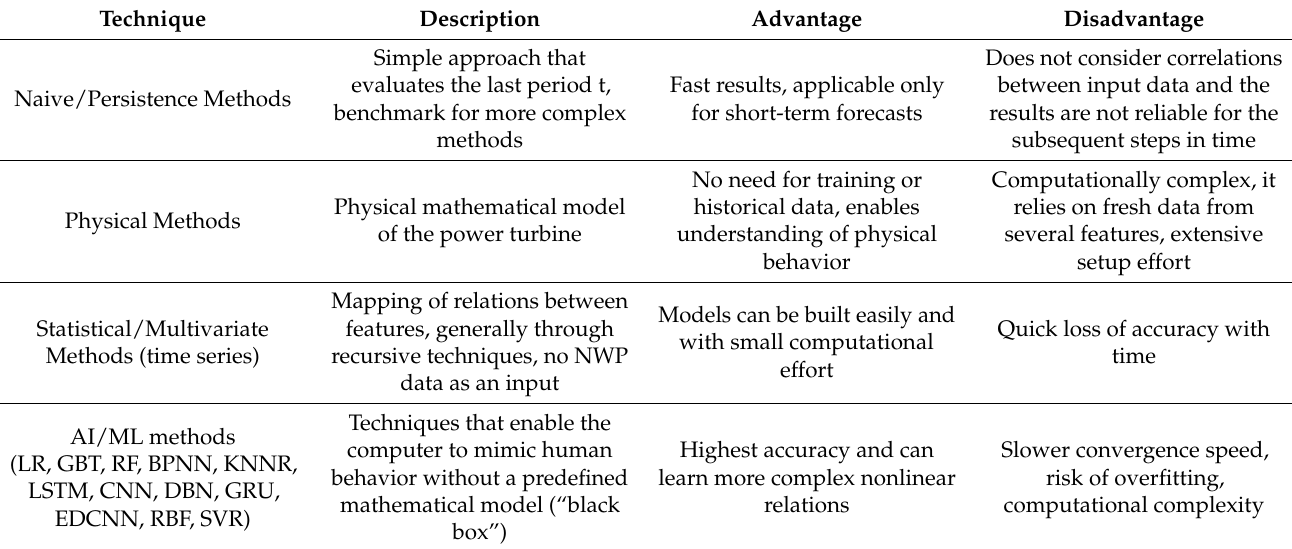
Table 3. Classification of forecasting